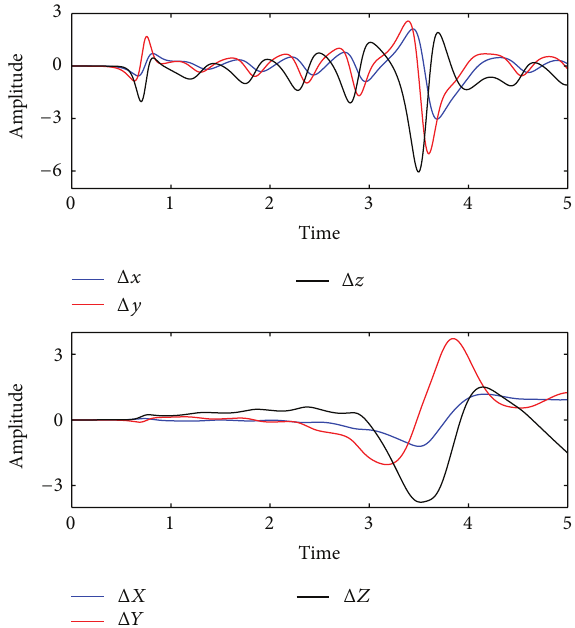
Figure 6: Difference between x (𝑟 0 ) and x (𝑟 0 + 0.01𝑟 0 ) for fast and slow